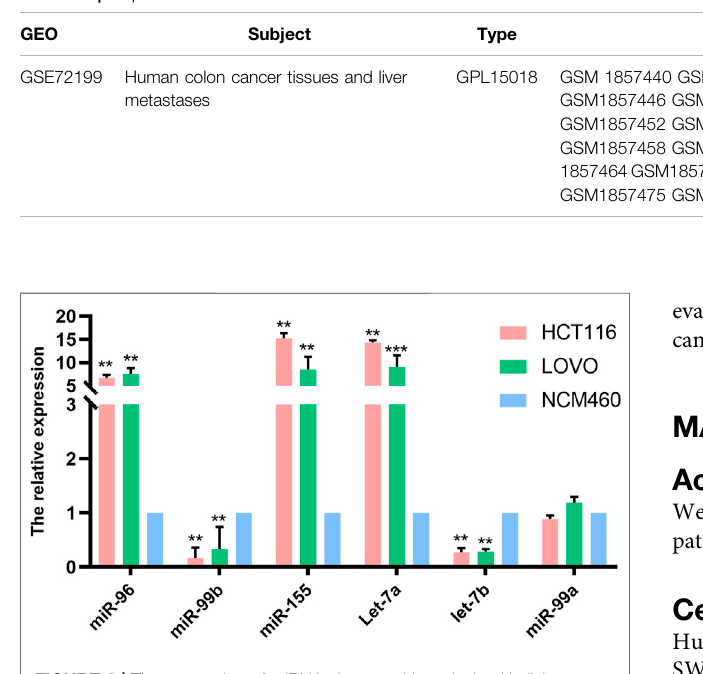
FIGURE 2 | The expression of miRNAs in normal intestinal epithelial NCM460 cell lines, HCT116 and LoVo were detected by qPCR. * Means p < 0.05, and ** means p < 0.01.